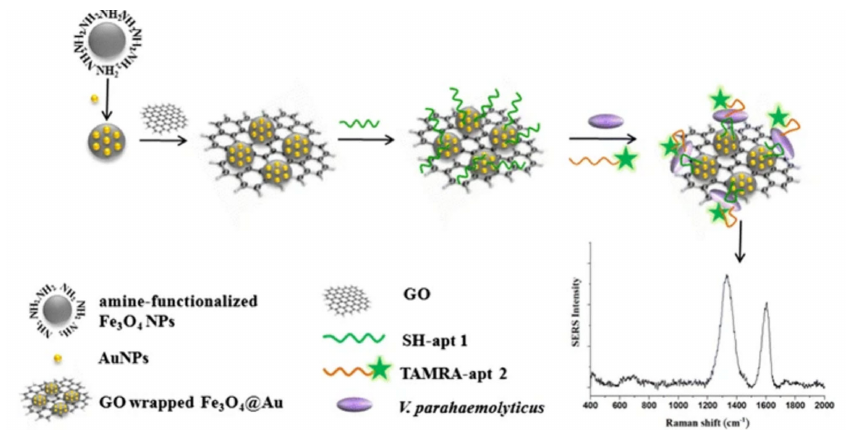
Figure 13. Schematic of SERS aptasensor based on graphene oxide (GO)-wrapped Fe 3 O 4 @Au nanostructures for V. parahaemolyticus determination (reprinted with permission from [141]).